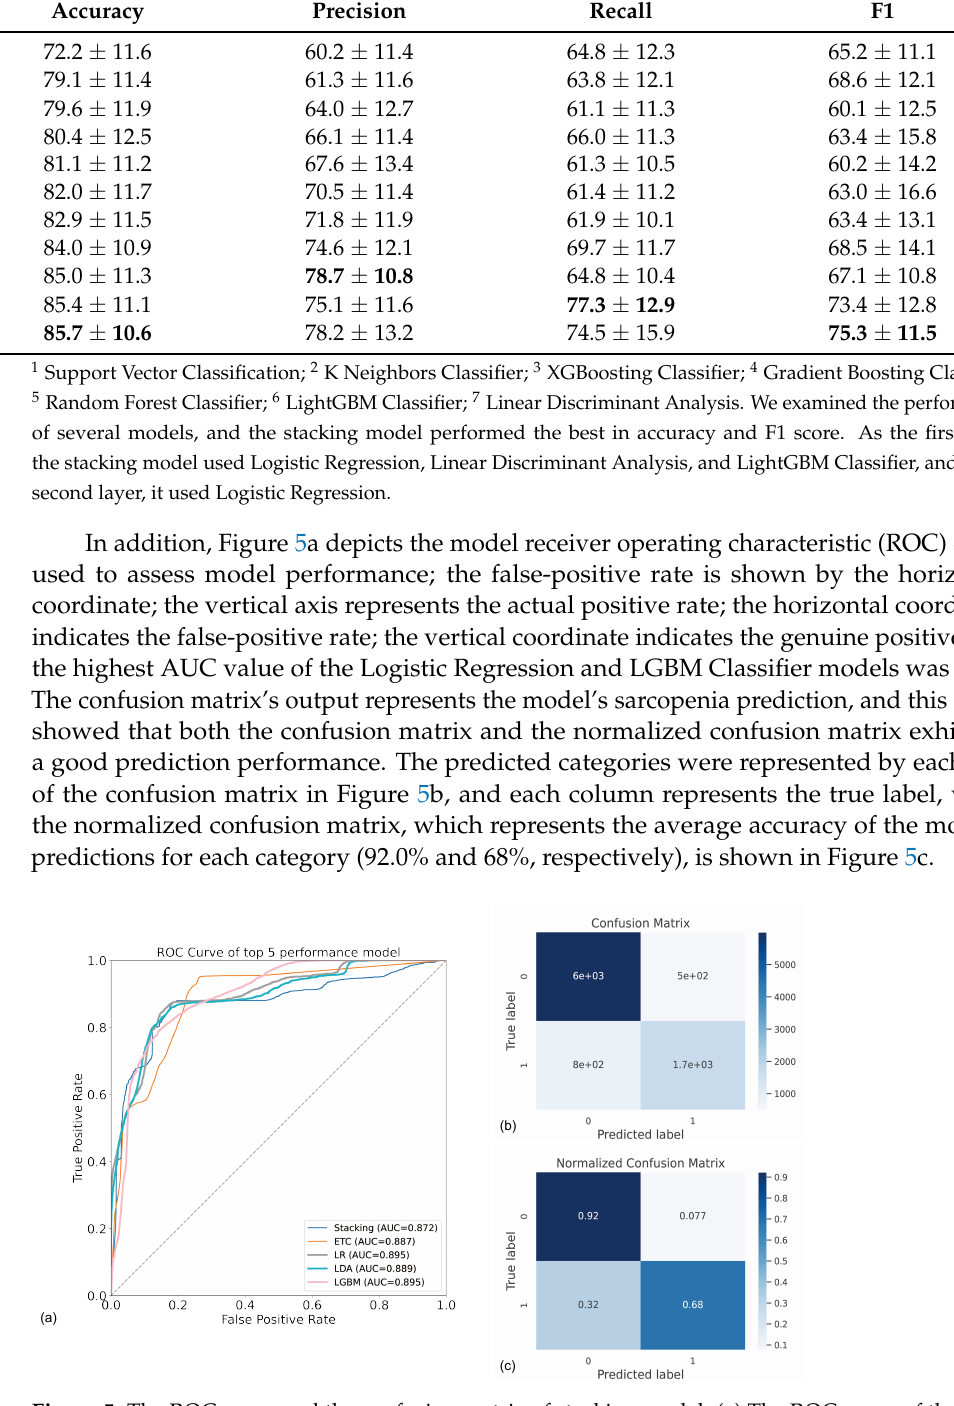
Figure 5. The ROC curve and the confusion matrix of stacking model. ( a ) The ROC curve of the top-5 performance models. ETC indicates Extra Tree Classifier; LR indicates Logistic Regression; LDA indicates Linear Discriminant Analysis; LGBM indicates LightGBM Classifier. ( b ) Confusion matrix; ( c ) normalized confusion matrix. The figure shows the model’s performance in identifying whether a participant has